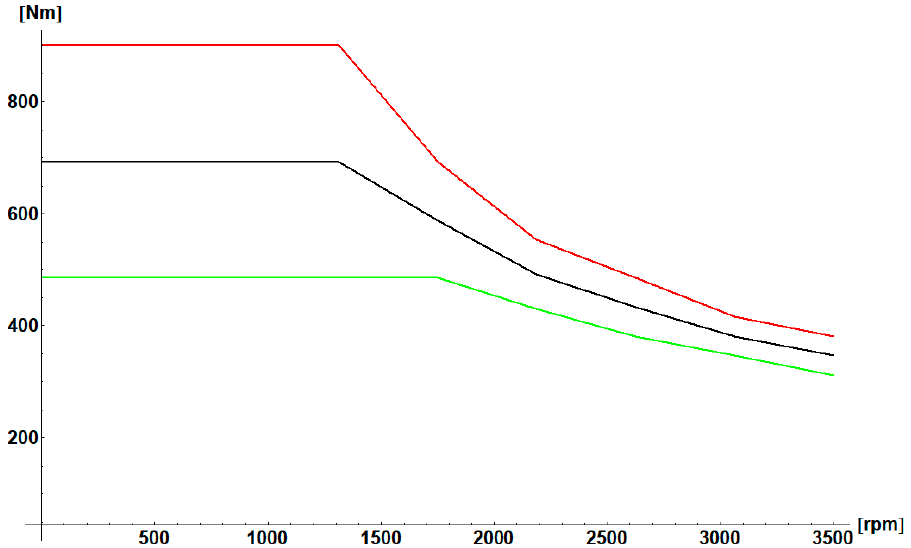
Figure 7. Typical torque pattern vs. rpm of a modern axial-flux electric motor. The red line is instantaneous torque (a few seconds). The green line is continuous torque. The black line is a torque level that can be output for minutes.